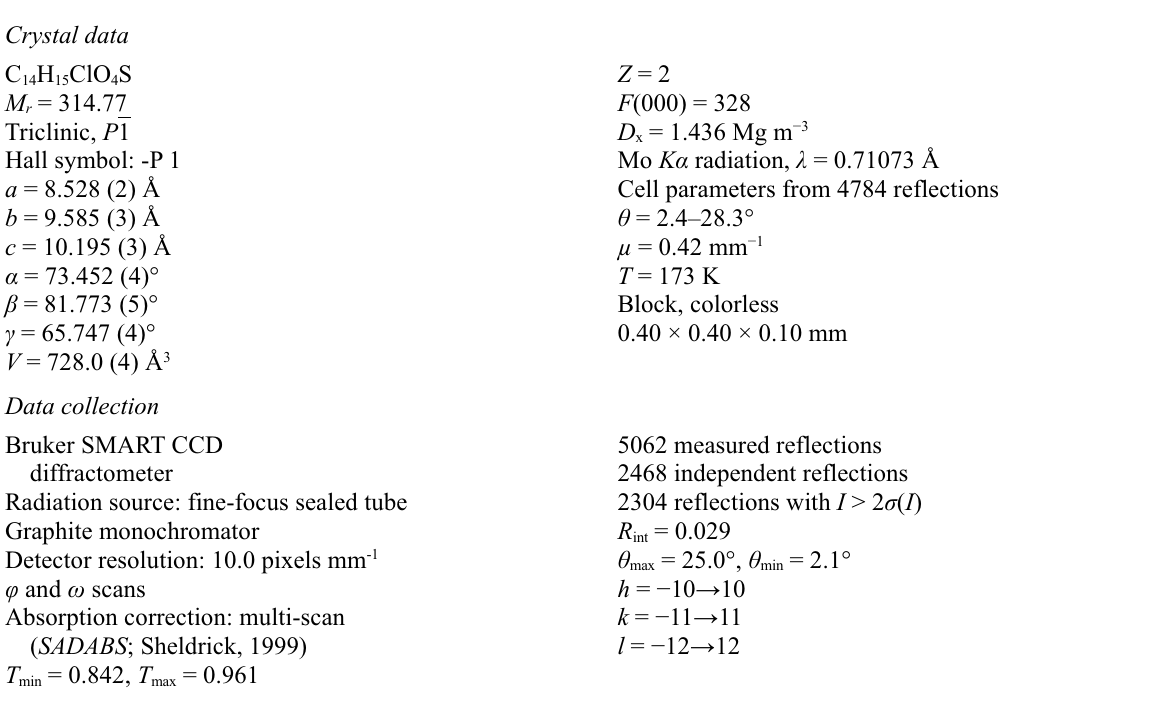
Intermolecular C—H···O hydrogen bonds (dotted lines) in the title compound. [Symmetry code: (ii) -x, -y+1, -z+1; (iii) - x, -y+1, -z+2; (iv) -x+1, -y+1, -z+1; (v) -x+1, -y+1, -z+2.] Propyl